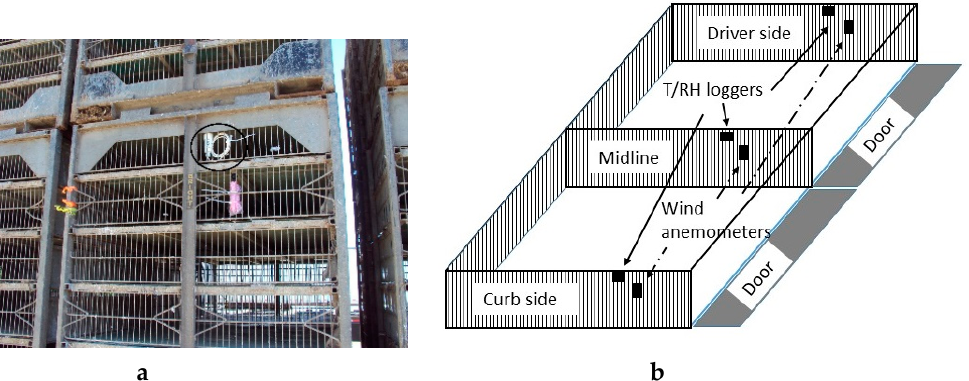
Figure 3. ( a ) Thermal and wind dataloggers secured on curbside of a transport module during a